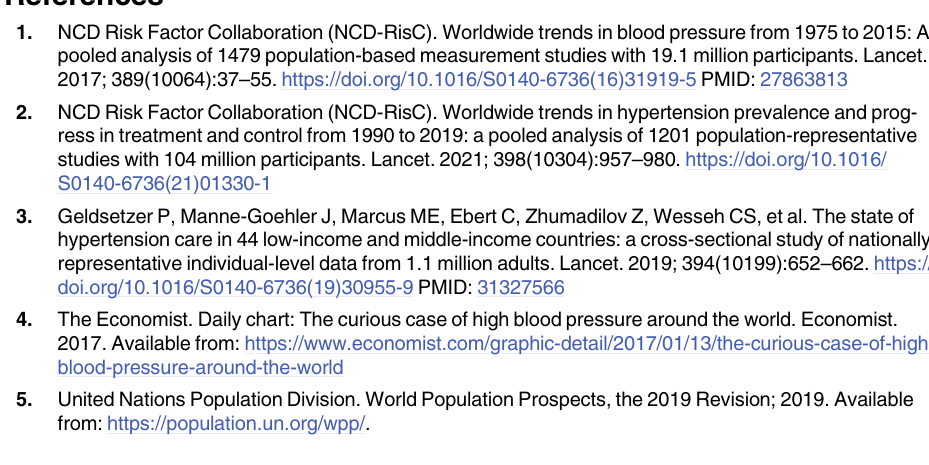
S2 Table. Health indicators for the MLSFH mature adult cohort in 2017 (respondents with BP measurement), and associations with systolic and diastolic blood pressure. S3 Table. Cross-sectional association of blood pressure and hypertension with age, 2013 and 2017. S4 Table. Prevalence of hypertension in 2013, by gender, and onset and persistence of hypertension during 2013–17, by gender. S5 Table. Predictors of changes in systolic blood pressure, onset and persistence of hyper- tension (additional findings). S6 Table. Prevalence of hypertension in 2013 and 2017 among MLSFH mature adults with blood pressure measurement in both